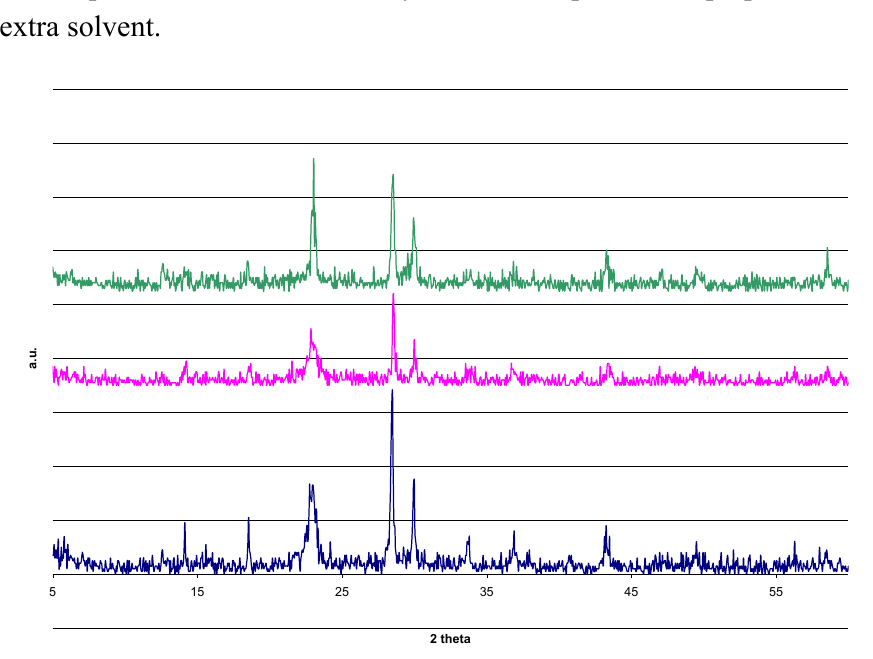
Figure 7. XRD patterns of activated catalysts from the precursors prepared with the three levels of extra